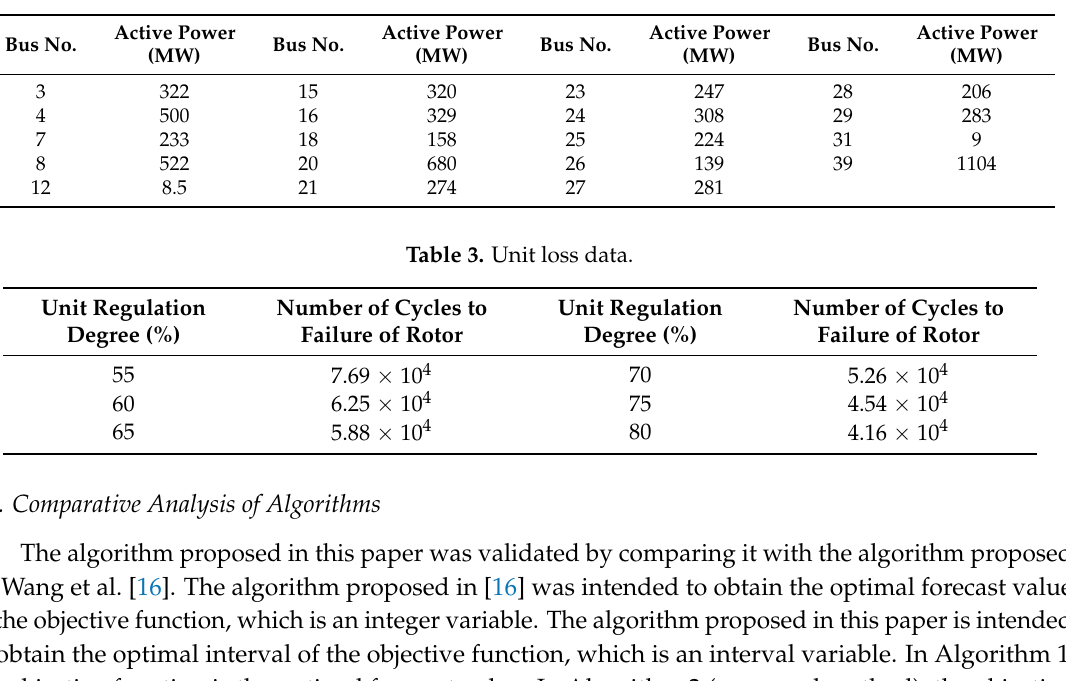
Table 2. Load data.